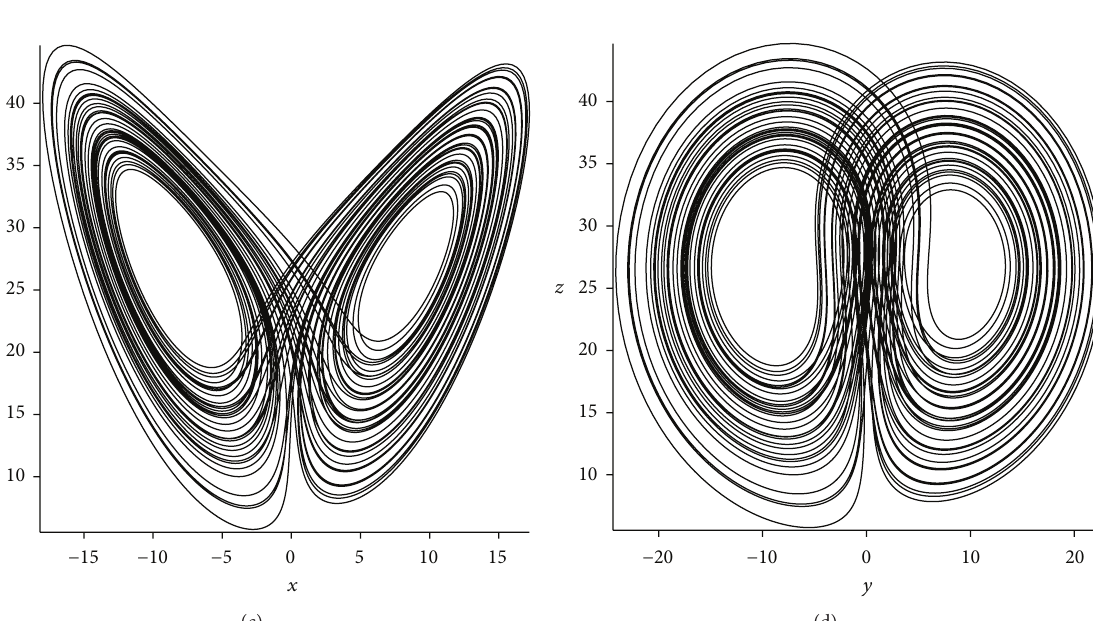
where 𝑒 1 = 𝑥 1 +𝑥 2 , 𝑒 2 = 𝑦 1 +𝑦 2 , and 𝑒 3 = 𝑧 1 +𝑧 2 . The control parameters are chosen as 𝐶 = (−1, 1, 1) , 𝐾 = (0, 6, 0) 𝛾 = 0.01 . Then the switching surface is equal